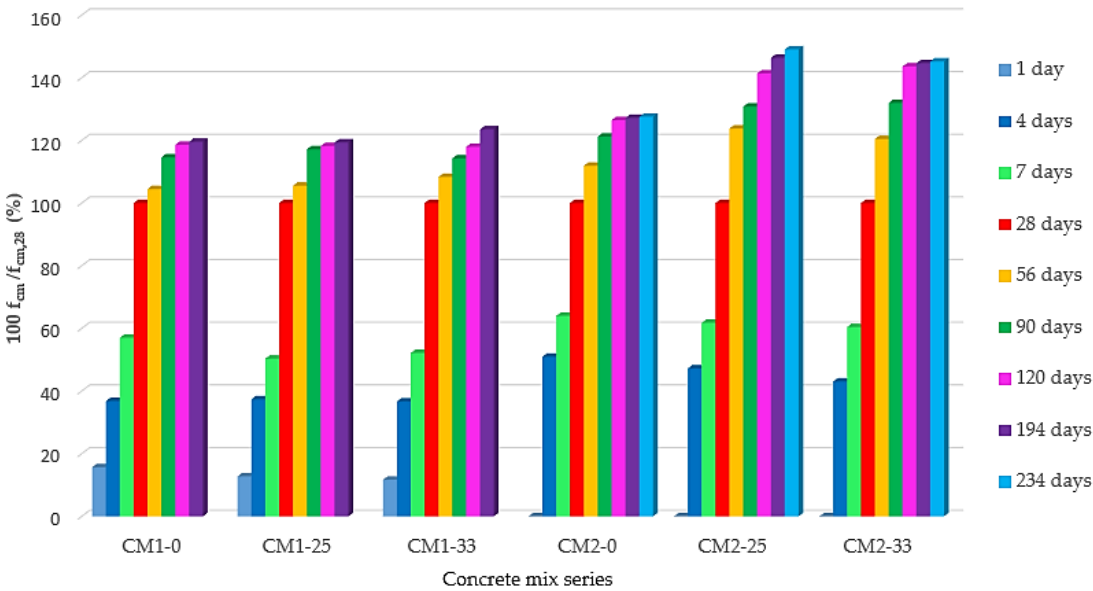
Figure 5. Relative changes in mean values of the compressive strength of concretes in relation to compressive strength in 28